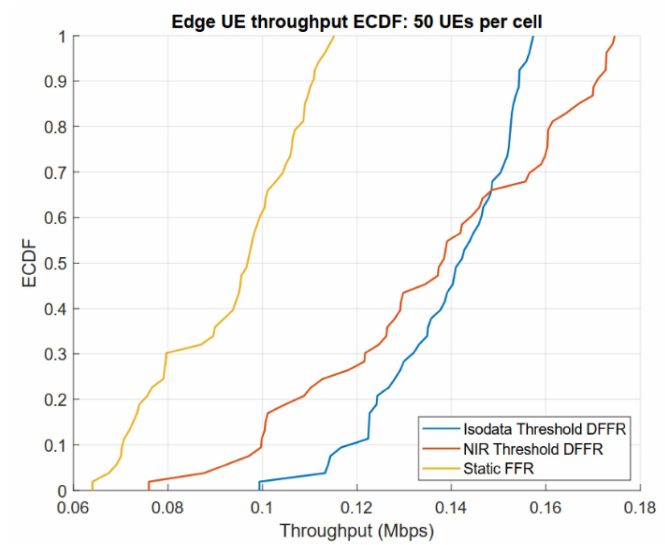
Figure 11. Edge UE throughput ECDF for 50 UEs per cell. Figure 12 represents peak edge UE throughput; Figure 13 represents the average edge UE throughput, while Figure 14 represents the fairness metric.